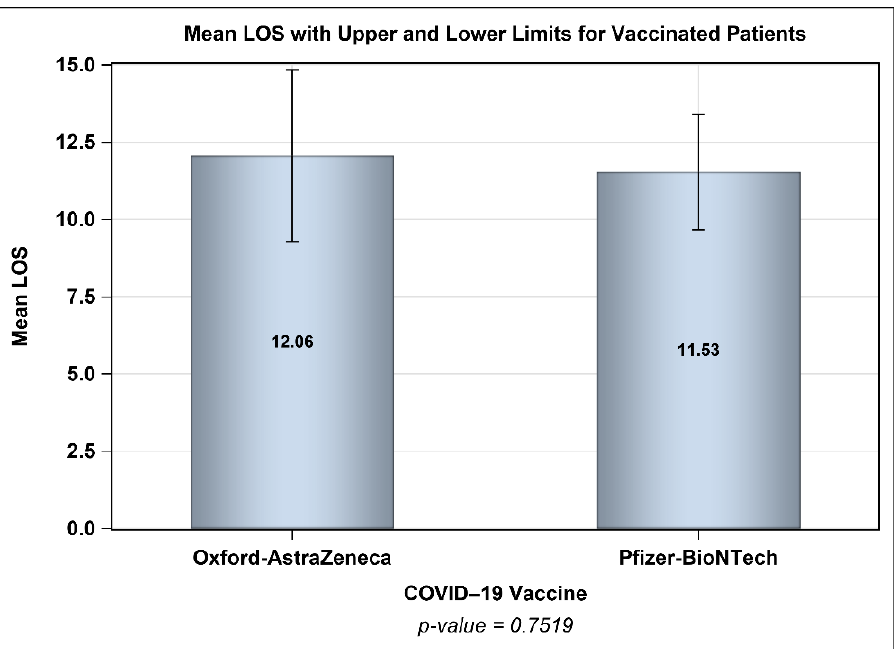
Figure 9. Mean length of stay (LOS) for vaccinated patients (Pfizer–BioNTech vs. Oxford–AstraZeneca; n = 252) prior to infection.